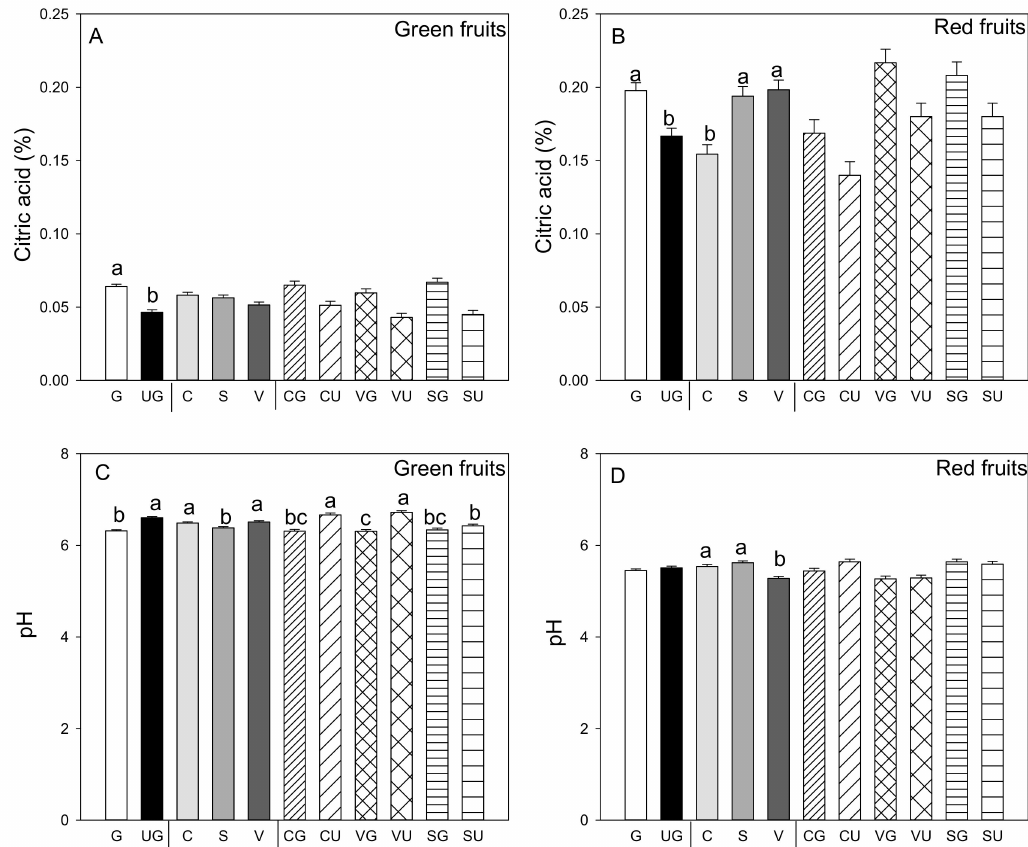
Figure 2. Titratable acidity ( A , B ) and pH values of pepper juice ( C , D ) in the green ( A , C ) and red ( B , D ) fruit produced by pepper landraces “Cuerno” (C), “Valencia” (V), and “Sueca” (S) grafted (G) or ungrafted (U) onto rootstock F1 NIBER ® . Values are the mean ± SE of three fruits per replicate (3 replicates) per landrace. Means were subjected to a two-way ANOVA with grafting and landrace as sources of variability. Different letters for the factors grafting and landrace, or their interaction, indicate significant differences at p < 0.05 using the LSD test. No letter indicates the non-significance of the F